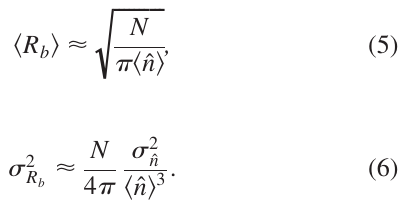
FIG. 6. The emittance growth is estimated from (a) radial profile measurements, and (b) WARP 2D PIC simulations. The emittance is calculated from Eq. (4), and is normalized to its initial value (cid:2) i . For the WARP simulations, 20 random error samples are used to calculate the ensemble-averaged emittance. The dotted lines indicate the background emittance growth in the absence of the applied noise.